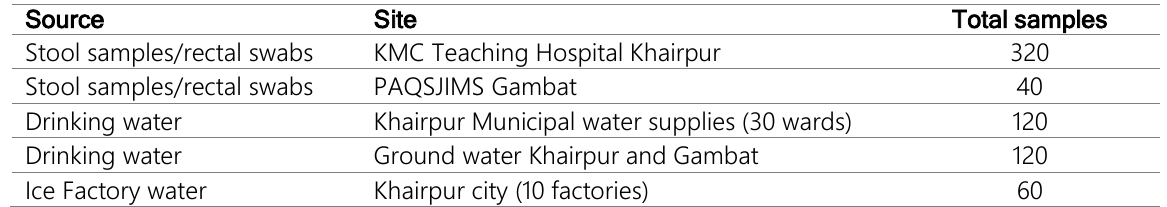
Table 1: Sampling Sources during this study for Isolation of V.